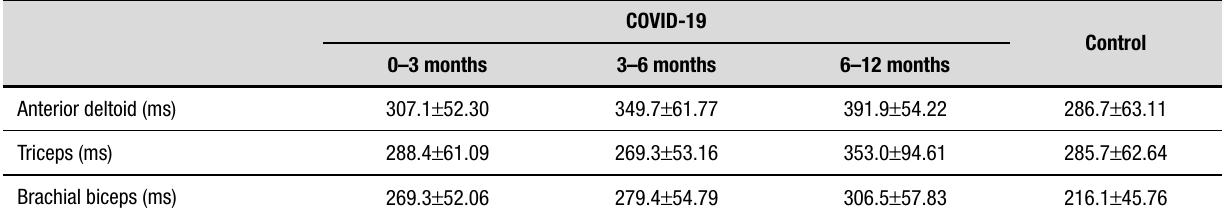
Figure 2. (A) Comparison of the choice reaction time of the anterior deltoid muscle between the control group and the COVID-19 group at baseline, 3-6 months, and 6-12 months after acute infection; (B) Comparison of the choice reaction time of the triceps muscle between the control group and the COVID-19 group at baseline, 3-6 months, and 6-12 months after acute infection; (C) Comparison of the choice reaction time of the brachial biceps muscle between the control group and the COVID-19 group at baseline, 3-6 months, and 6-12 months after acute infection. Table 2. Mean and standard deviation of choice reaction time values of anterior deltoid, triceps, and brachial biceps of individuals after COVID-19 infection over 1 year and control